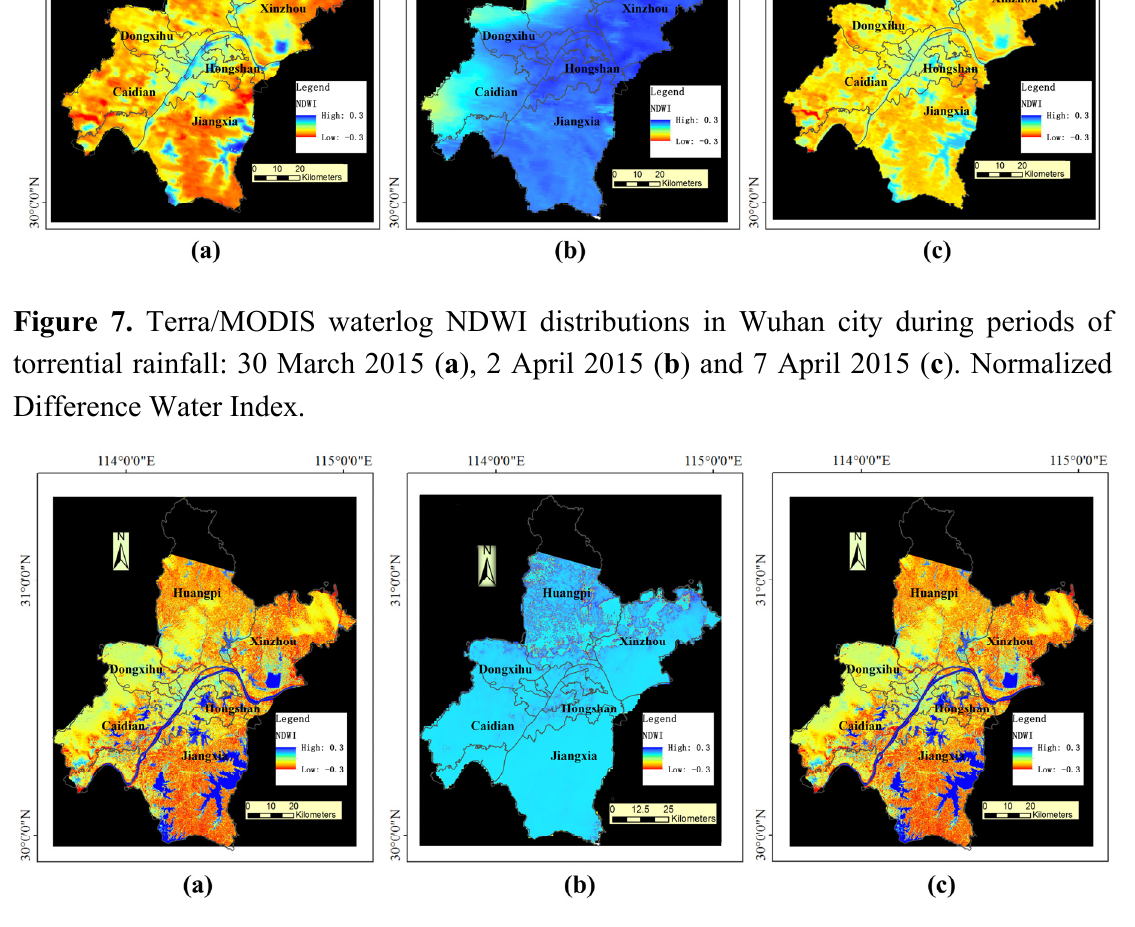
Figure 8. Landsat 8 OLI waterlog NDWI distributions in Wuhan city during periods of torrential rainfall: 27 March 2015 ( a ), 2 April 2015 ( b ) and 07 April 2015 ( c ).